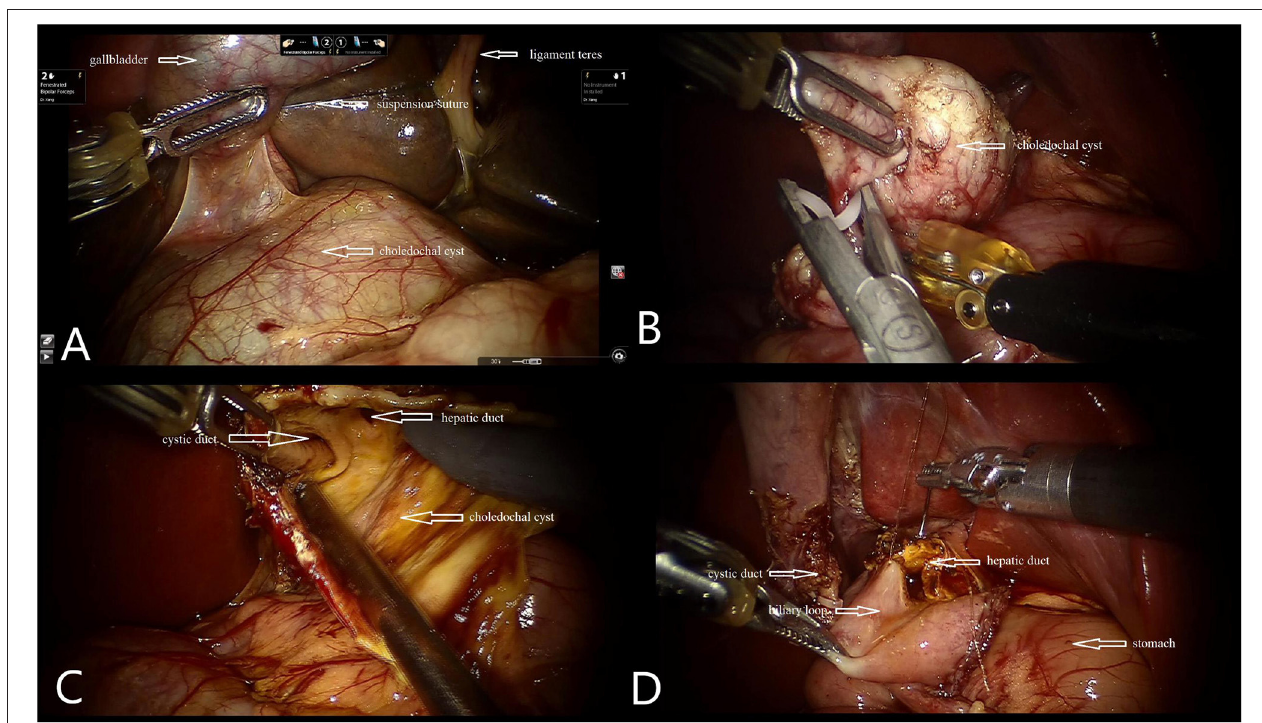
FIGURE 2 | Intraoperative photographs. (A) Suspension of gallbladder and ligamentum teres. (B) Ligation of the distal end of the cyst. (C) Confirm cystic duct and hepatic duct. (D) Hepaticojejunostomy with robotic